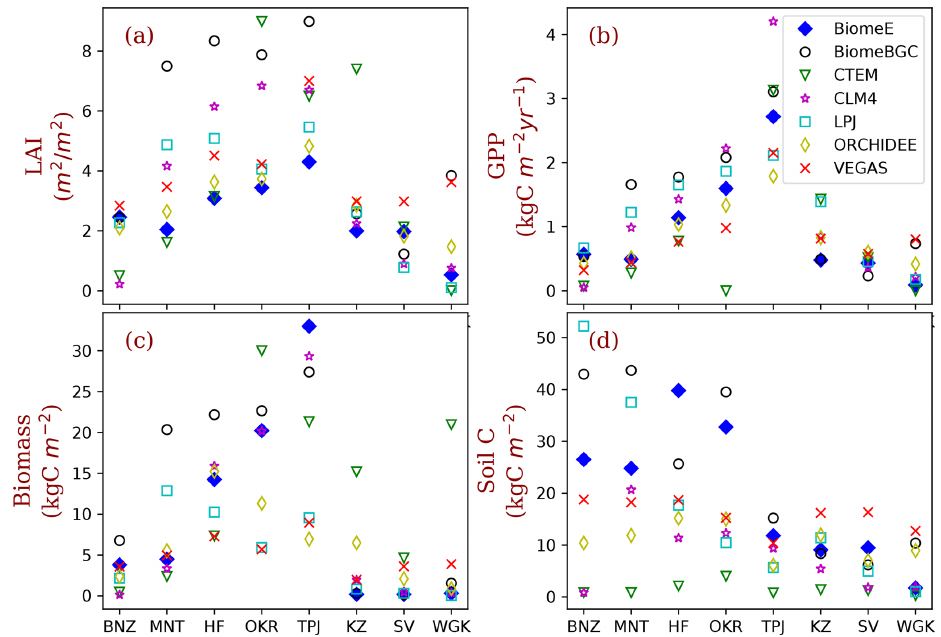
Figure 9. Site-level comparison with MsTMIP models. The BiomeE predictions are from the full demography. The abbreviations of the eight sites (corresponding to model grid cells) and their coordination, dominant PFTs, and climatic conditions are given in Table 2. (See Fig. S12 in the Supplement for the single-cohort BiomeE simulations).